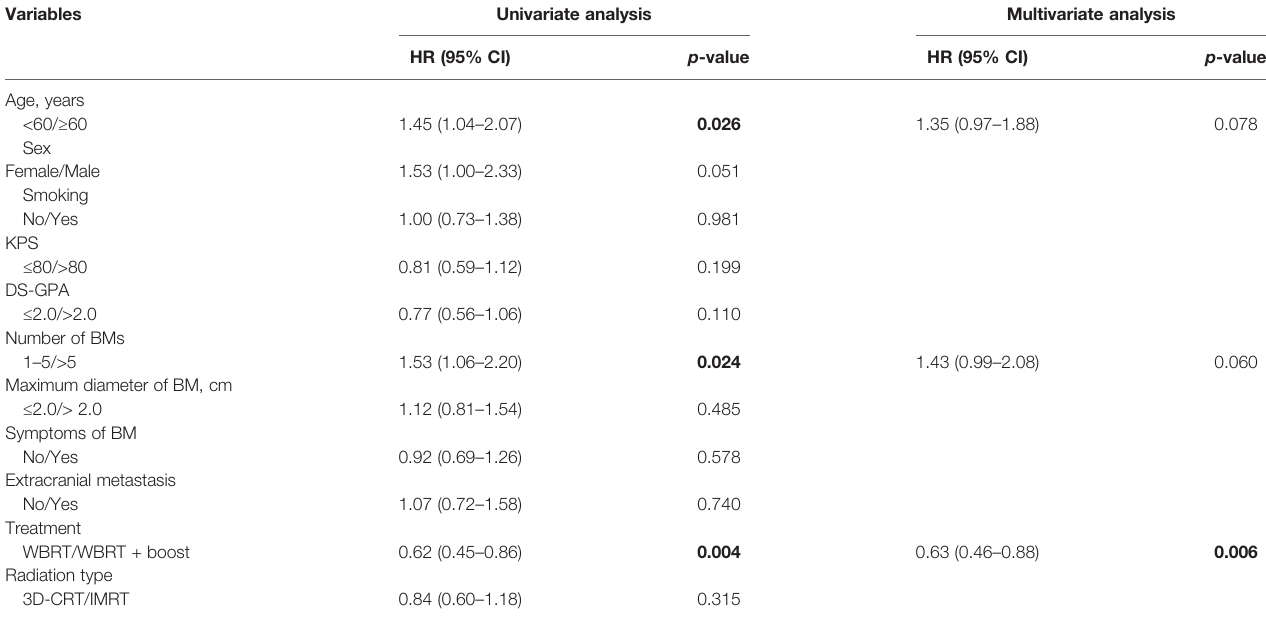
TABLE 3 | Univariate and multivariate analyses of factors in fl uencing iPFS of 180 SCLC patients with BM. Variables Univariate